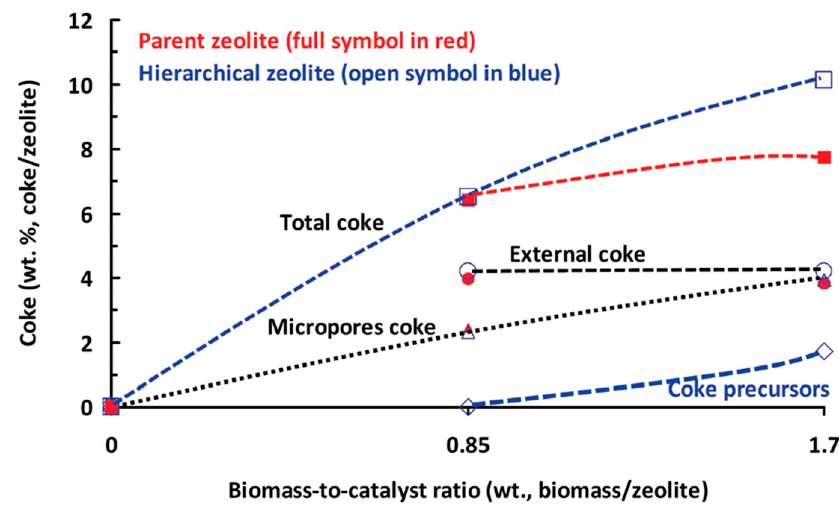
Figure 8. Weight distribution of various coke types as a function of the biomass-to-catalyst ratio. (Adapted from [128]. Copyright 2017 Royal Society of Chemistry).